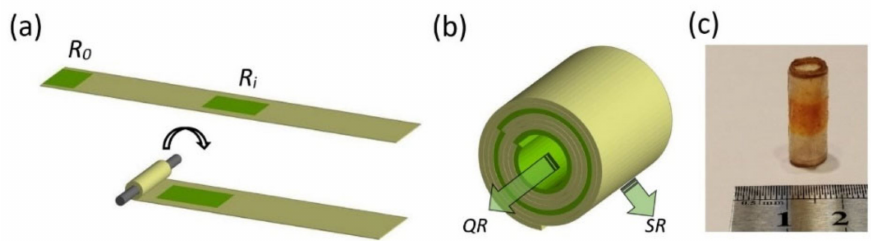
Figure 1. Formation of the capsules using the rolling-up approach. ( a ) Rolling of a gelatin strip with two drug reservoirs around a cylindrical stick. ( b ) Cross-section of the capsule with two reservoirs. The arrows symbolize the QR from the cavity of the capsule and the SR through the gelatin layers. ( c ) A photo of a rolled-up cylinder-like